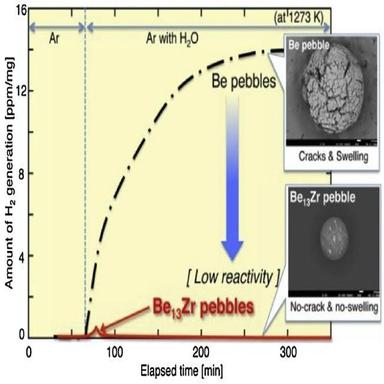
The hydrogen generated amount normalized by the weight of pebbles of the as-granulated Be12Zr compared to pure Be pebbles at 1273 K.